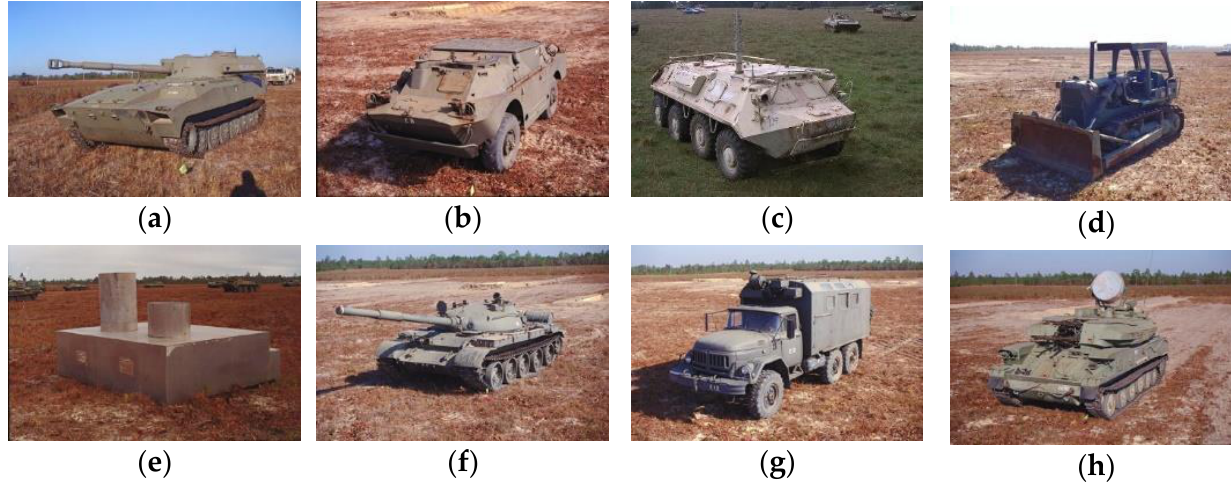
Figure 5. Classes in the MSTAR dataset: ( a ) 2S1; ( b ) BRDM-2; ( c ) BTR-60; ( d ) D7; ( e ) SLICY; ( f ) T62; ( g ) ZIL-131; ( h ) ZSU- 23-4.